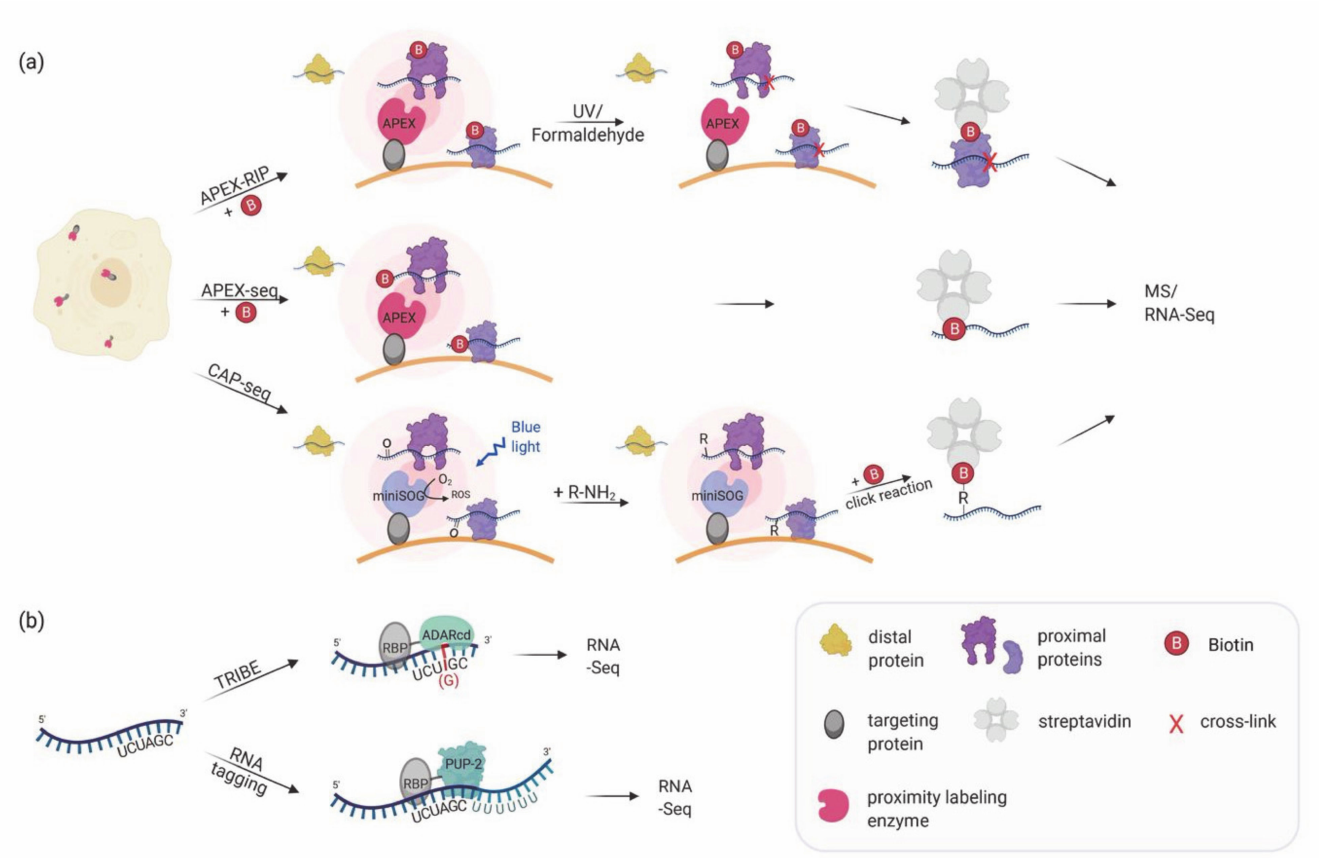
Figure 2. ( a ) Proximity labeling strategies for mapping subcellular transcriptomes. APEX or miniSOG are targeted to a specific subcellular location. In APEX-RIP, APEX catalyzes the biotinylation of proximal proteins, and proximal RNAs are crosslinked by either UV light or formaldehyde treatment. In APEX-seq, APEX directly biotinylates RNA. In CAP-seq, miniSOG oxidizes proximal RNA molecules upon blue light illumination. The oxidized RNAs are crosslinked to an alkylamine probe which can be linked to biotin-azide in a click reaction. APEX-RIP, APEX-seq, and CAP-seq make use of streptavidin-purification of the biotinylated proteins/RNAs followed by MS and/or RNA-Seq. ( b ) In vivo proximity labeling strategies for identifying RNA partners of an RBP. RNA targets of RBPs can be identified by changing the RNA sequence upon the interaction. In TRIBE the RBP of interest is fused to the catalytic domain of ADAR which mediates adenosine to inosine editing (in red) of the interacting RNA(s). The inosine is read as a guanosine when analyzed by RNA-Seq allowing the identification of editing events as A-to-G transition. In RNA tagging the RBP of interest is fused to a poly(U) polymerase (PUP-2) that attaches a poly-uracil chain at the 3 (cid:48) end of interacting RNAs. The uracil tail is then used to identify targets during RNA